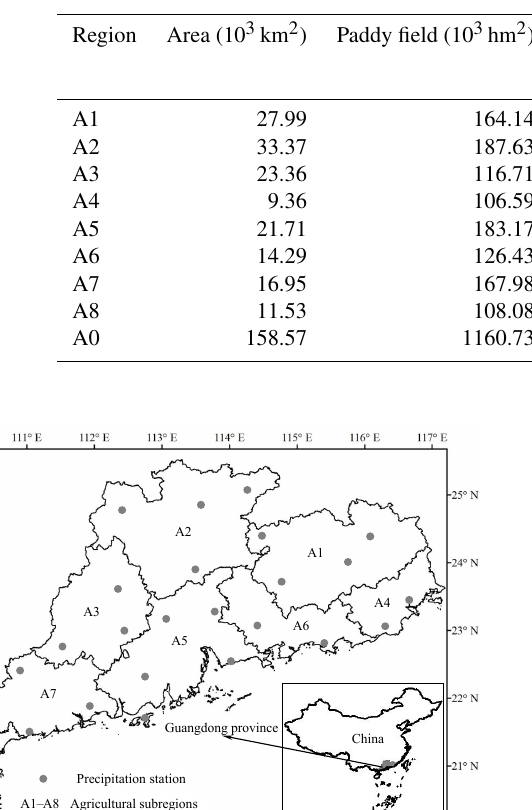
Table 2. Area, paddy field and precipitation of the sub-regions and entire region. The A0 region refers to the entire region of Guangdong Province.